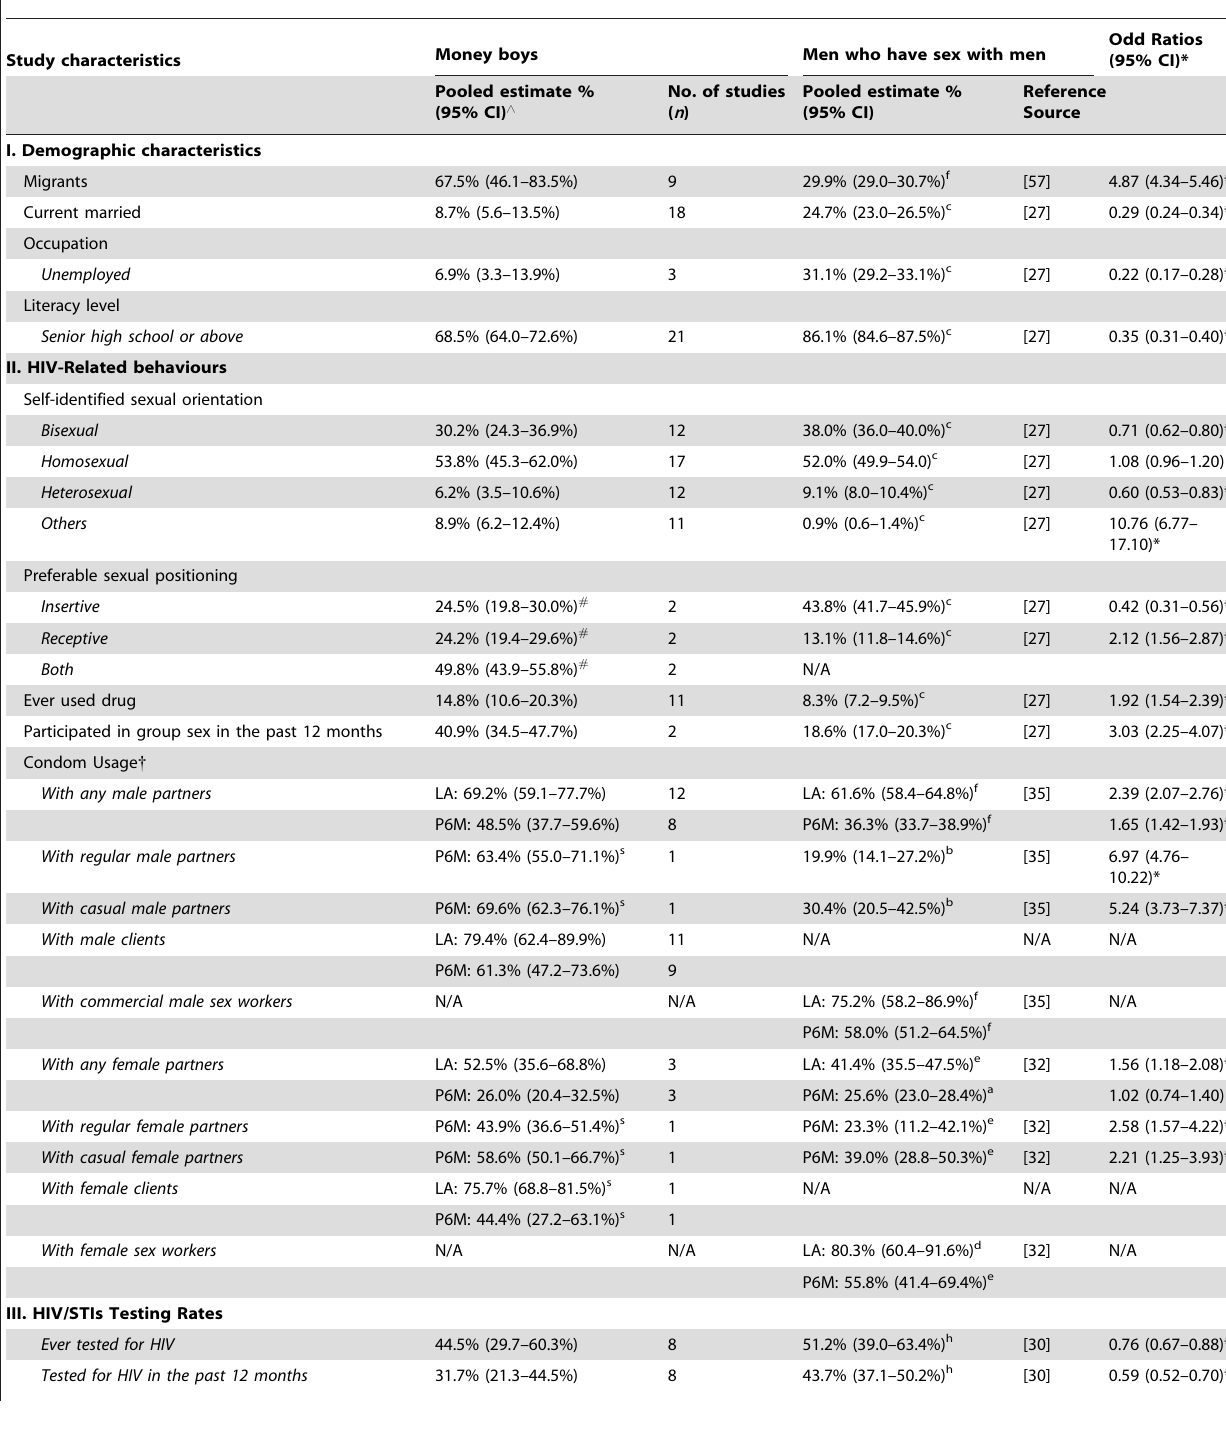
Table 4. Comparison between Chinese money boys and men who have sex with men in their demographic characteristics, HIV- related behaviours and HIV/STIs testing rates and burden of infectious